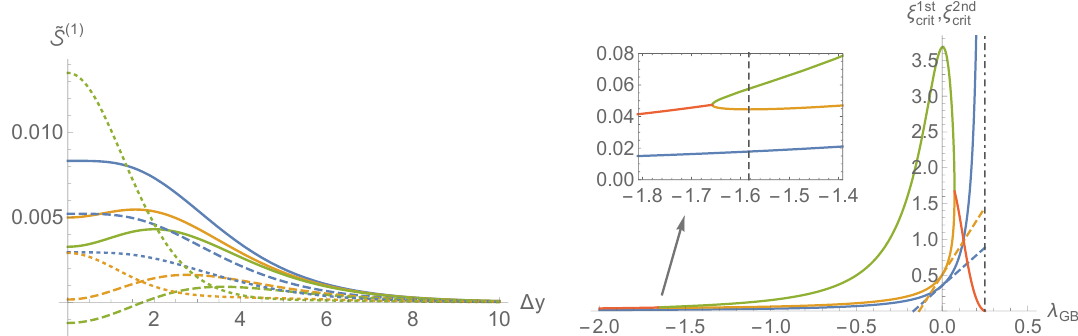
Figure 4 . Left: plots for ~ S (1) (cid:17) S (1) (cid:28) 4 = 3 =w 4 (cid:1) x 4 for some representative values of (cid:24) = (cid:28) (cid:0) 1 w (cid:0) 3 = 2 = 3 0 0 f 0 ; 0 : 1 ; 0 : 2 g depicted in blue, orange and green, respectively. Solid lines correspond to (cid:21) = 0 GB (in(cid:12)nite coupling result) while the dashed and dotted lines correspond to (cid:21) = (cid:0) 0 : 5 and (cid:21) = (cid:0) 2, GB GB respectively, all cases for second-order hydrodynamics. Right: plot of (cid:24) 1st (blue) and the two crit branches of (cid:24) 2nd (orange and green) as a function of (cid:21) . In the ranges of (cid:21) 2 ( (cid:0)1 ; (cid:0) 1 : 657) crit GB GB and (cid:21) 2 (0 : 073 ; 1 = 4], the correlator is positive but non-monotonic as a function of (cid:24) . Here, (cid:24) 2nd crit GB is found instead by requiring a monotonic decay at late times and is depicted in red. The dashed blue and orange lines correspond to the perturbative results to leading order in (cid:21) . The vertical GB line indicates the maximum allowed value for (cid:21) = 1 = 4. The behavior observed for negative GB values of (cid:21) in the range (cid:21) 2 ( (cid:0) 1 : 583 ; 0) is what is expected for a theory that (cid:13)ows from GB GB strong to weak coupling, i.e. (cid:24) 2nd decreases as the coupling decreases. However, (cid:24) 2nd increases in crit crit the range (cid:21) 2 ( (cid:0) 1 : 657 ; (cid:0) 1 : 583). The small square on top of the (cid:12)gure is a zoomed-in version GB of the same around this region. The dashed vertical line there signals the value of (cid:21) = (cid:0) 1 : 583 GB for which d(cid:24) 2nd =d(cid:21) = 0. The discontinuous jump in the derivative of (cid:24) 2nd at (cid:21) = (cid:0) 1 : 657 is crit crit GB GB likely to be an artifact of a truncated hydrodynamic gradient expansion or a truncated gravitational derivative